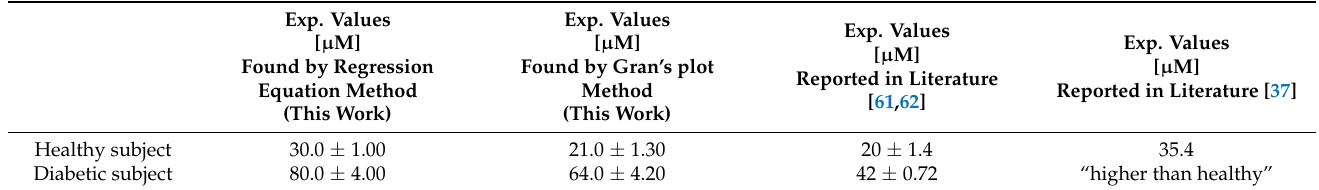
Figure 6. Measurement of H 2 O 2 concentration in urine samples from ( a ) healthy and ( b ) diabetic subjects. Experimental calibration curves and confidence intervals are built in matrix and hydrogen peroxide concentrations are found by using the linear regression method and Gran’s plot method (in the insets). Each point (black filled circles) represents the mean of at least three repeated determinations. Black star symbols and dotted lines represent the experimental application of the regression equation method. In the insets, coloured star symbols represent the experimental application of the Gran’s plot method. Table 4. Experimental values of hydrogen peroxide concentration found in fresh human urine from healthy and diabetic subjects, determined in this work under nitrogen atmosphere, comparing them with those present in three works reported in the literature.